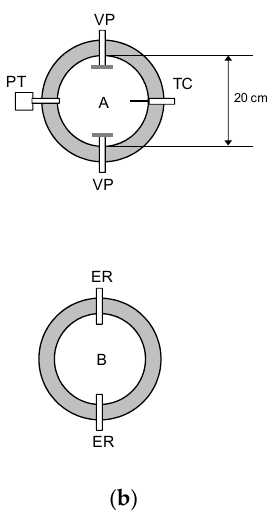
Figure 2. Conceptual drawing of the high-pressure cell used in this study; PT: Pressure transducer, TC: Thermocouple, VP: Piezoelectric plates for P-wave velocity measurements, ER: Electrode for electrical resistance measurements. ( a ) Vertical cross-sectional drawing of the cell. ( b ) Horizontal cross-sectional drawing of the layers A1–A5 and B1–B4, respectively.